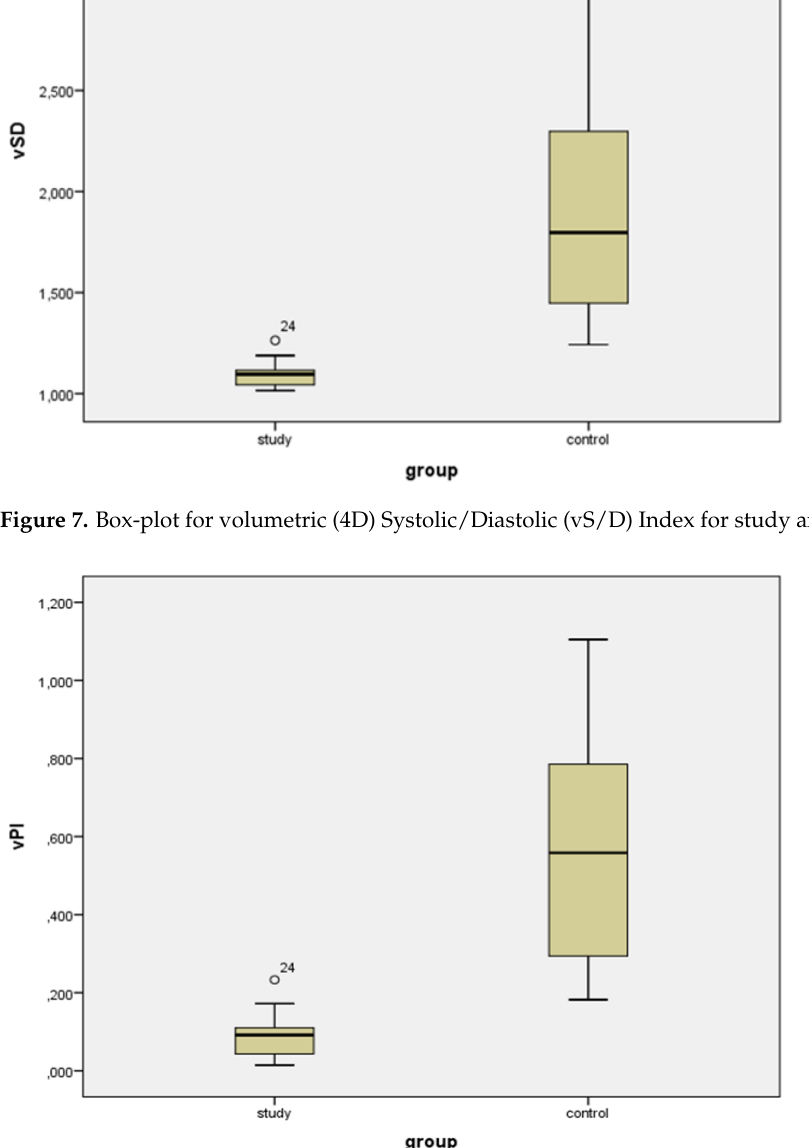
Figure 8. Box-plot for volumetric (4D) Pulsatility Index (vPI) for study and control group.